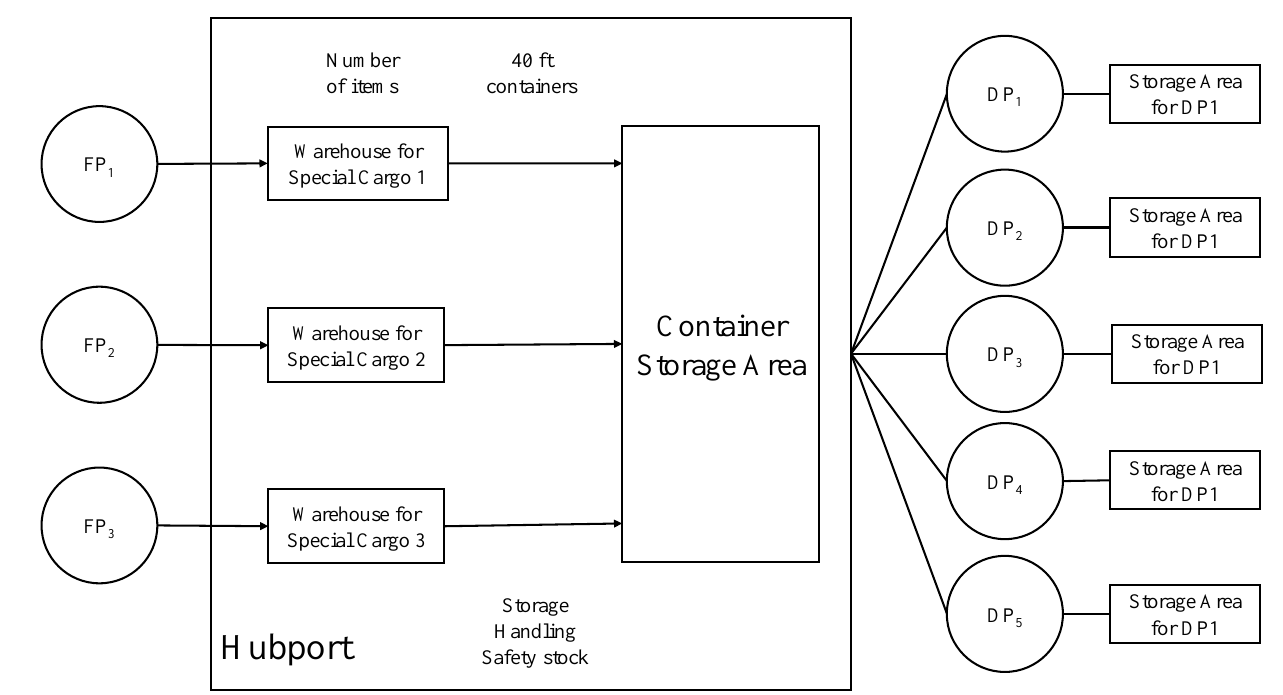
Figure 1. Structure of the proposed model for maritime supply